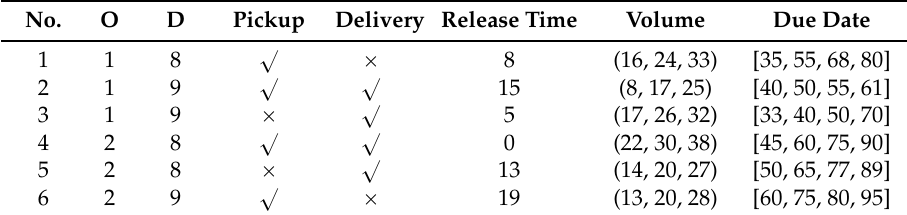
Table 3. Customer information of the commodity flows.